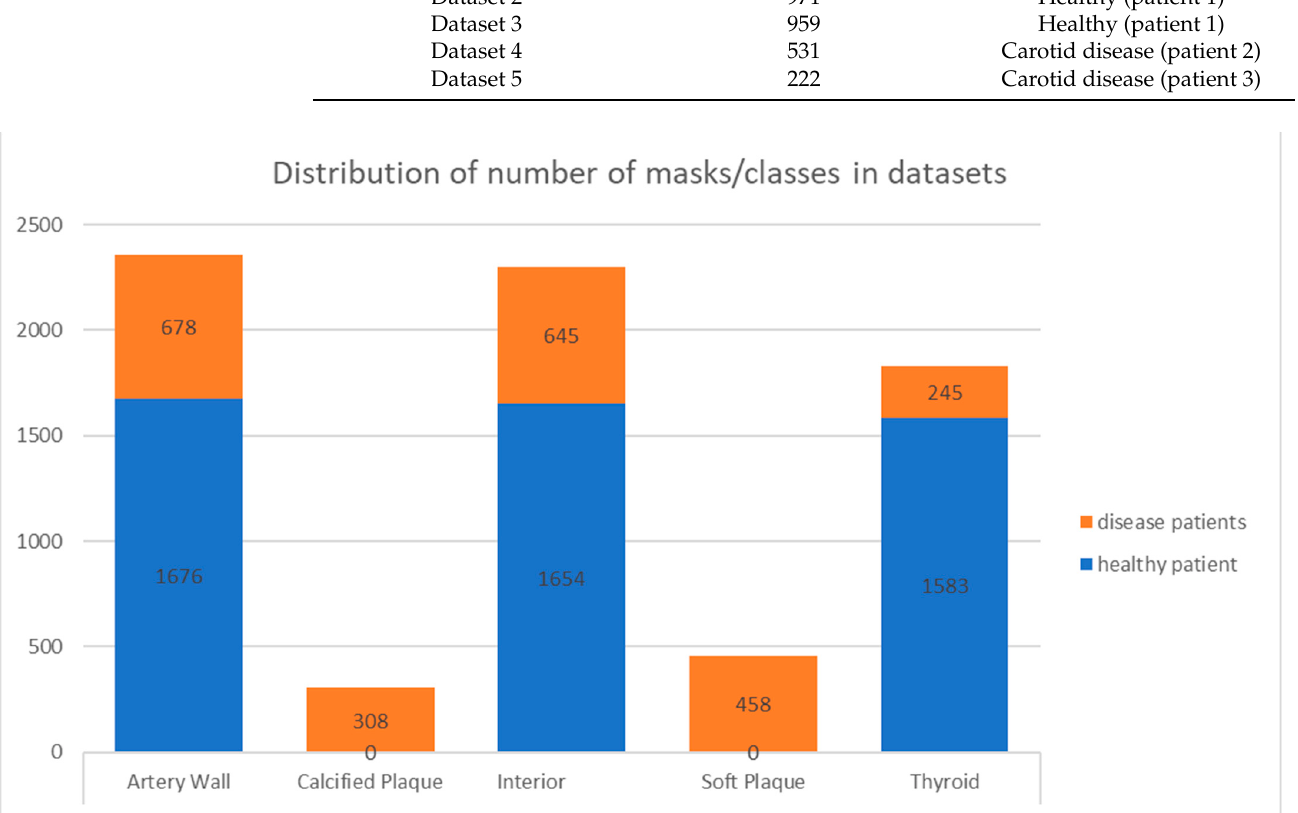
Table 2. The frames selected from the acquired US data for the carotid-artery-disease patients.